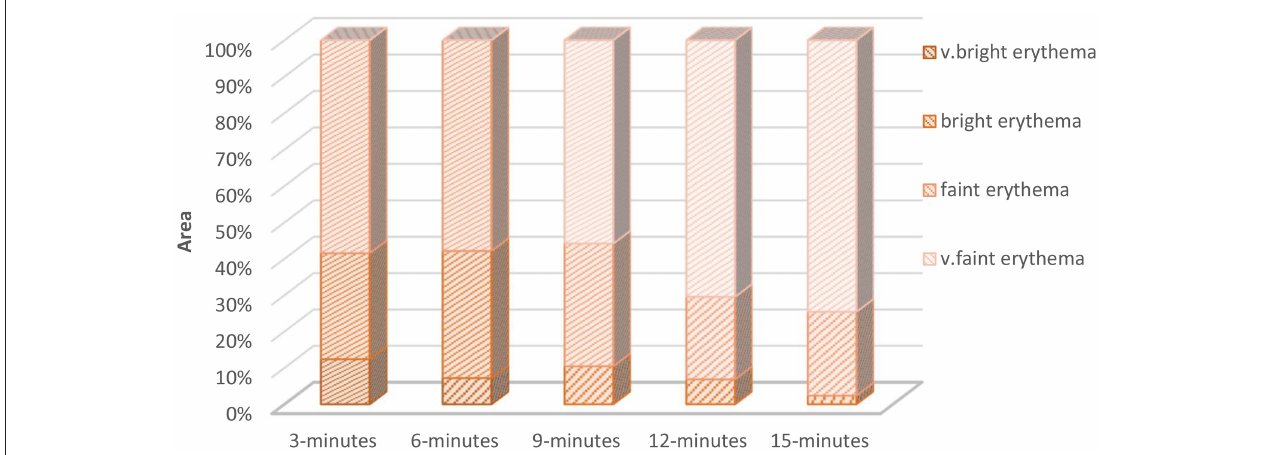
FIGURE 6 | The relative percentage of each erythema grade measured at different time after initial induction. This figure shows an example of erythema from a single volunteer ventral arm side evolution through multiple image sequence cycles. The initial measurements show high erythema intensities (very bright, bright, and faint erythema regions). As time goes by, the skin recovers and the erythema intensity decreases. By the time of 15 minutes, most of the ROI was occupied by the lowest erythema grade (very faint